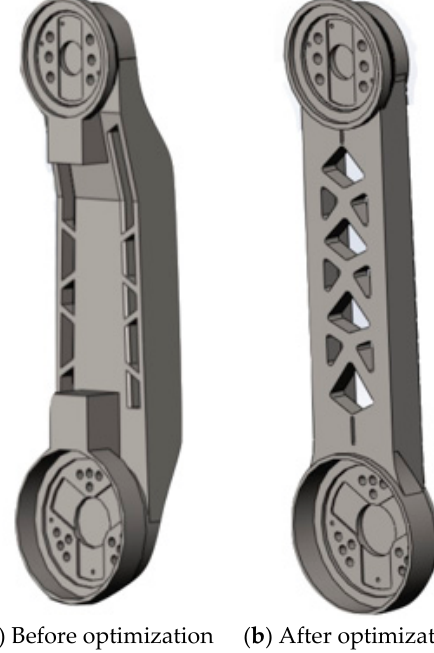
Figure 21. Comparison of the upper arm between before and after optimizations: ( a ) before optimization and ( b ) after optimization.